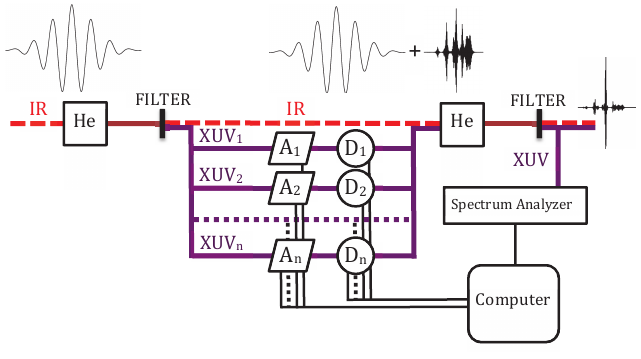
Figure 1. (Color online) Schematic illustration of the numerical experiment. An intense IR laser pulse interacts with a first gas target—helium in this case. The output is filtered in a particular spectral region—and occasionally split in several pulses, in order to modify the XUV intensity, which is achieved by using variable light attenuators A . The attenuated i XUV pulses are combined with the original IR pulse with a given delay provided by variable i delay lines D . The combination of the IR+XUV pulses generates harmonics in a second gas i i target. The output from the second interaction region is analyzed by a spectrum analyzer for optimization of the spectral amplitude in an iterative loop procedure managed by a